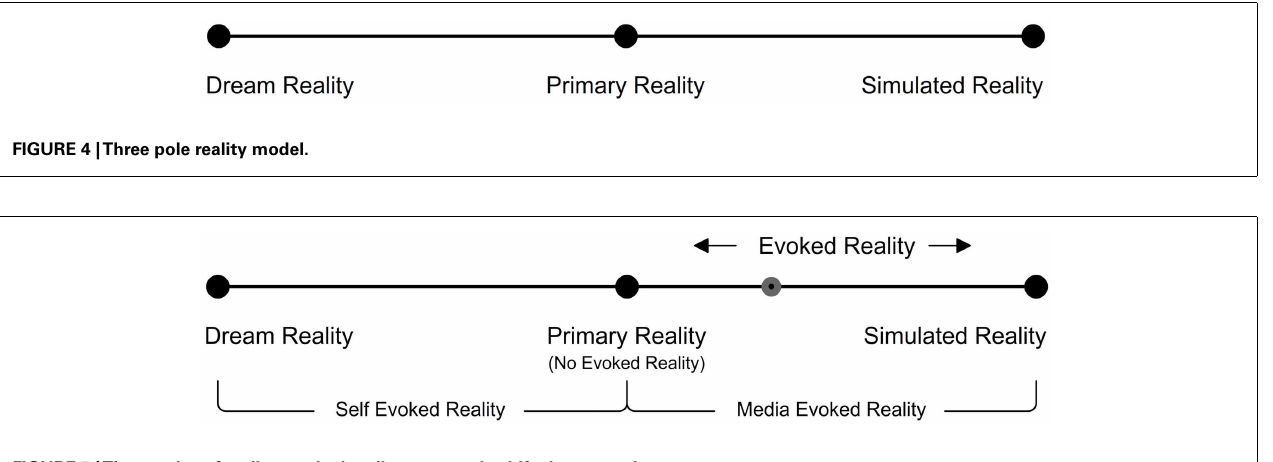
FIGURE 5 |Three poles of reality: evoked reality constantly shifts between